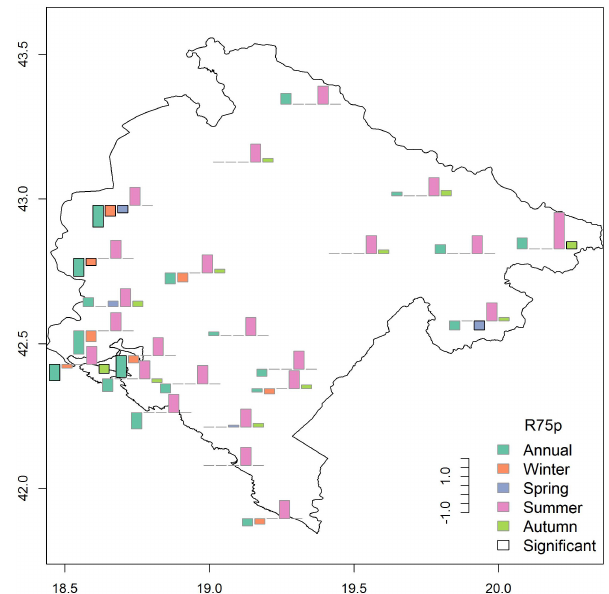
Figure 5. Decadal trends in the annual and seasonal Simple Daily Precipitation Index (SDII) in %dec − 1 .